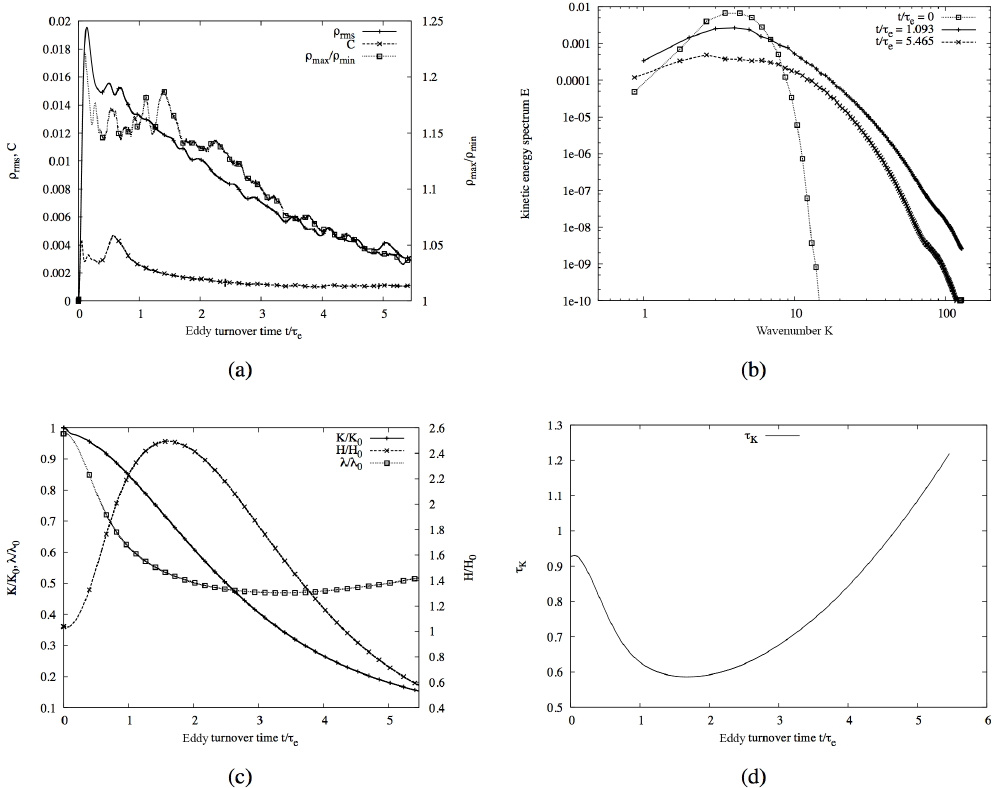
Figure 4. Evolution of dynamical quantities in DHIT with Re λ (cid:39) 116 and Ma rms = 0 . 2 at t/τ e = 5 . 465. (a) Density fluctuations ρ rms , compressibility C and density contrast ρ max /ρ min ; (b) evolution of the energy spectrum E (k) ; (c) non-dimensional kinetic energy K/K 0 , enstrophy H / H 0 and Taylor microscale λ T /λ T , 0 ; (d) Kolmogorov timescale τ η